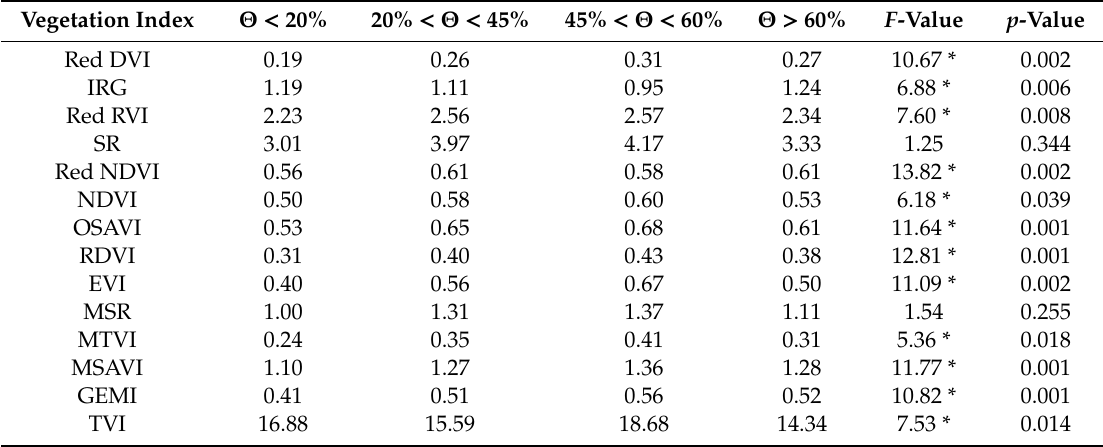
Table 5. Analysis of variance for Dianthus vegetation indices for di ff erent water content levels ( Θ ). Vegetation Index Θ <